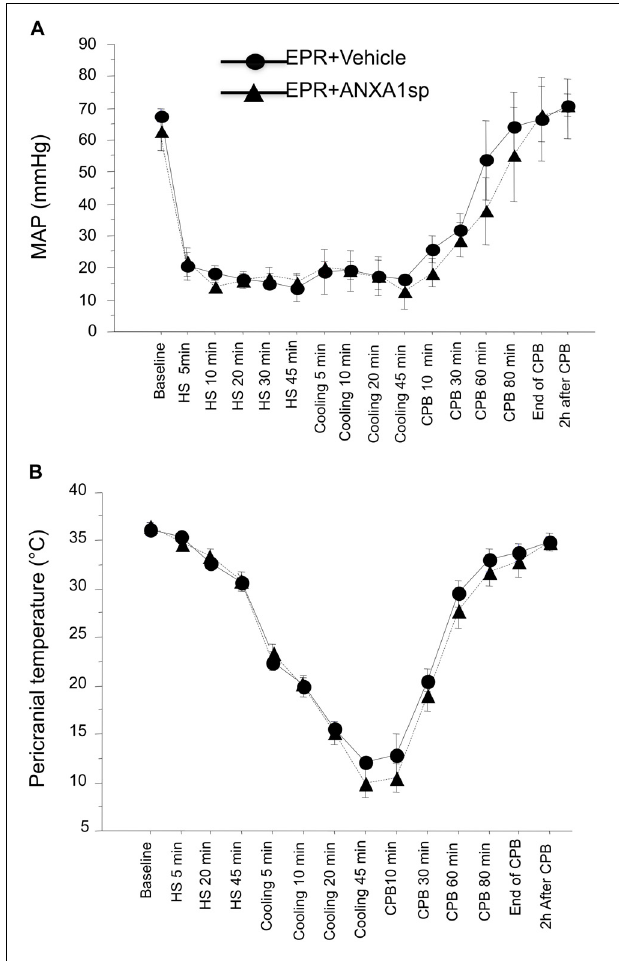
FIGURE 2 | Time course of mean arterial pressure (A) and pericranial temperature (B) during the EPR experimental protocol for vehicle (control) and ANXA1sp-treated animals. Data presented as mean ± SD ( n =